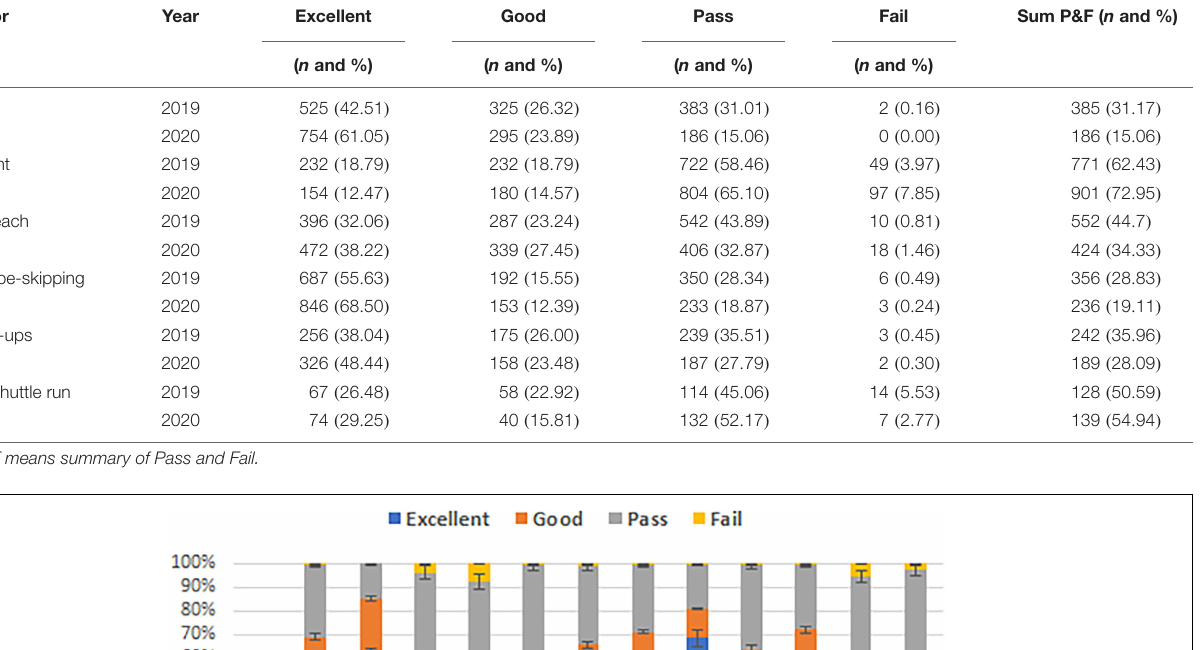
TABLE 2 | The physical fitness rank distribution.